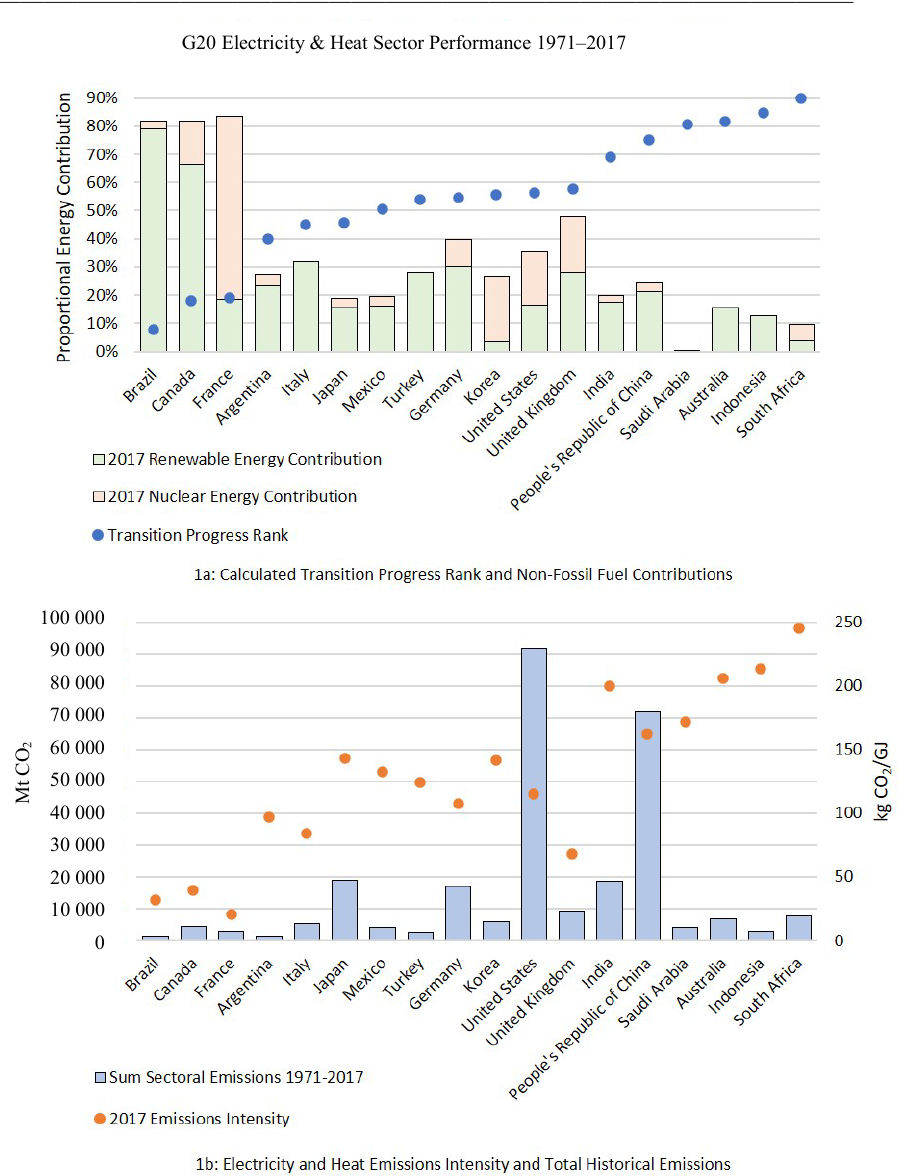
Fig. 1. G20 Electricity and Heat Sector CO 2 Intensity Analysis Results by